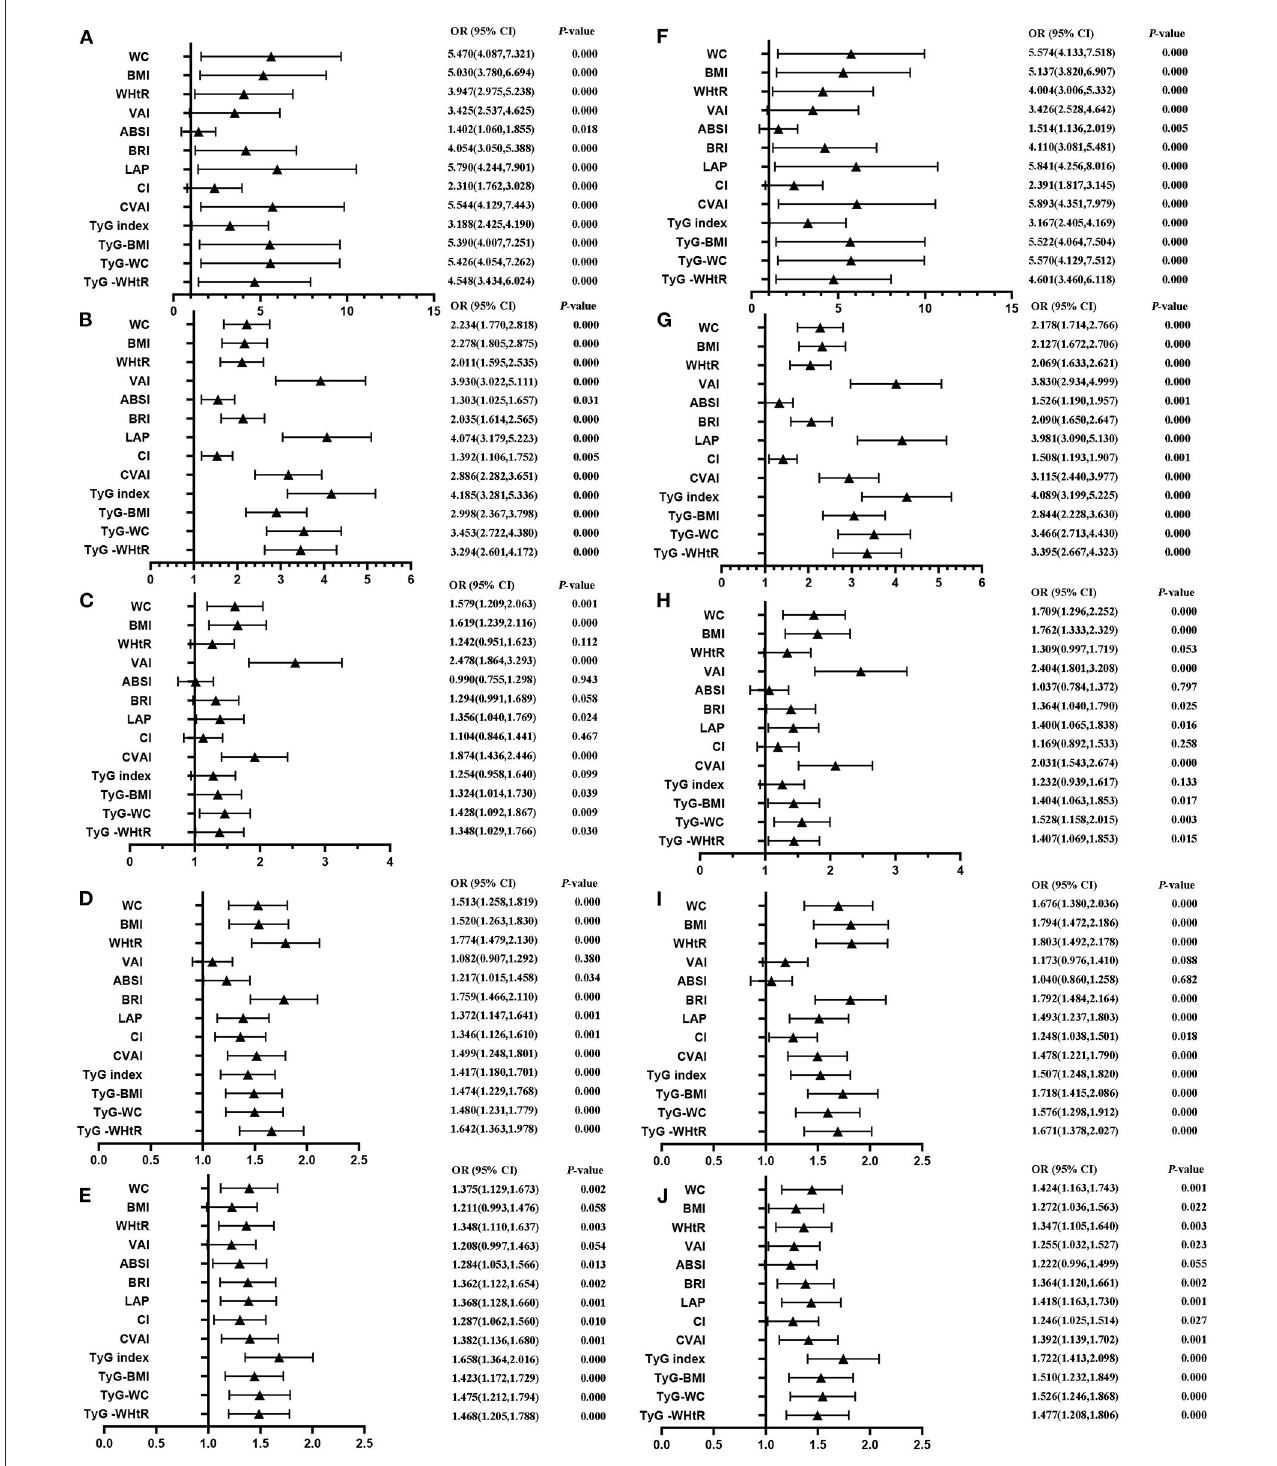
FIGURE5 Forest diagram of OR before and after adjustment of confounding factors for male. (A) Mets unadjust, (B) Elevated triglycerides unadjusted, (C) Reduced HDL-C unadjusted, (D) Elevated blood pressure unadjusted, (E) Elevated fasting glucose unadjusted, (F) Mets adjusted, (G) Elevated triglycerides adjusted, (H) Reduced HDL-C adjusted, (I) Elevated blood pressure adjusted, (J) Elevated fasting glucose adjusted. Adjusted OR: Adjusted for age, educational levels, marital status, live place, current smoking, alcohol drinking, activities, exercises, chronic